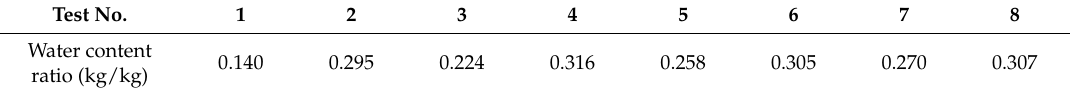
Table 3. The test results of the water content of the saturated solid